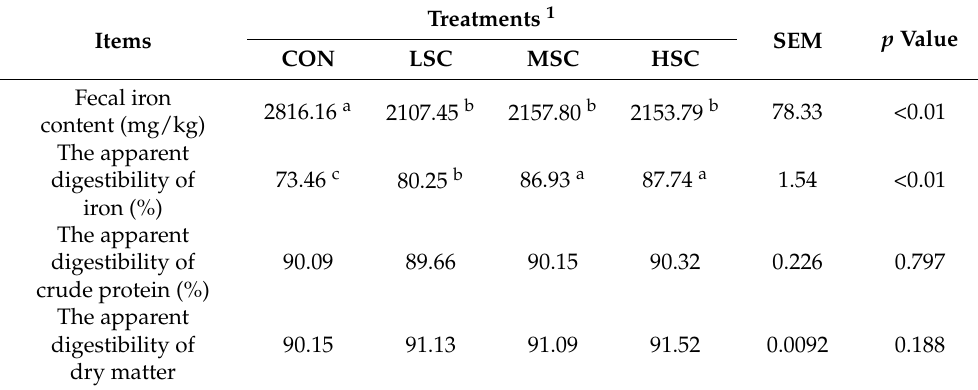
Table 2. Effects of yeast iron on digestibility of iron and protein in weaned